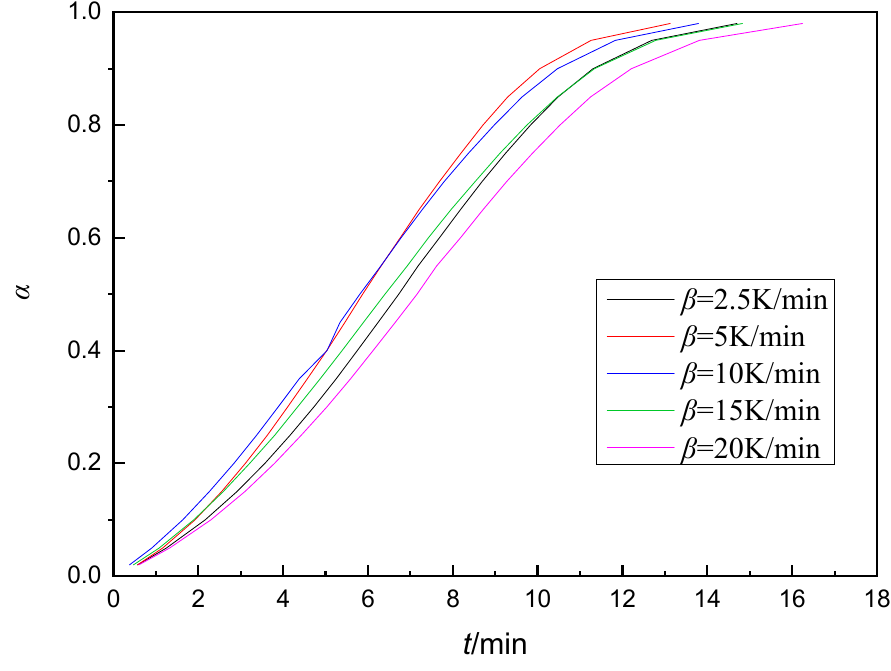
Figure 5. The conversion-time curves of AG-80/m-XDA system ( phr = 26) calculated by non-model method at 90 °C with different heating rates ( β = 2.5 K/min, 5 K/min, 10 K/min, 15 K/min, and 20 K/min) .